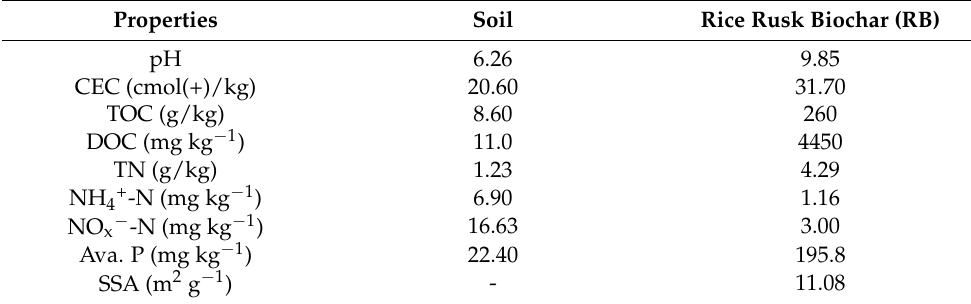
Table 1. Basic physical and chemical properties of soil and biochar.